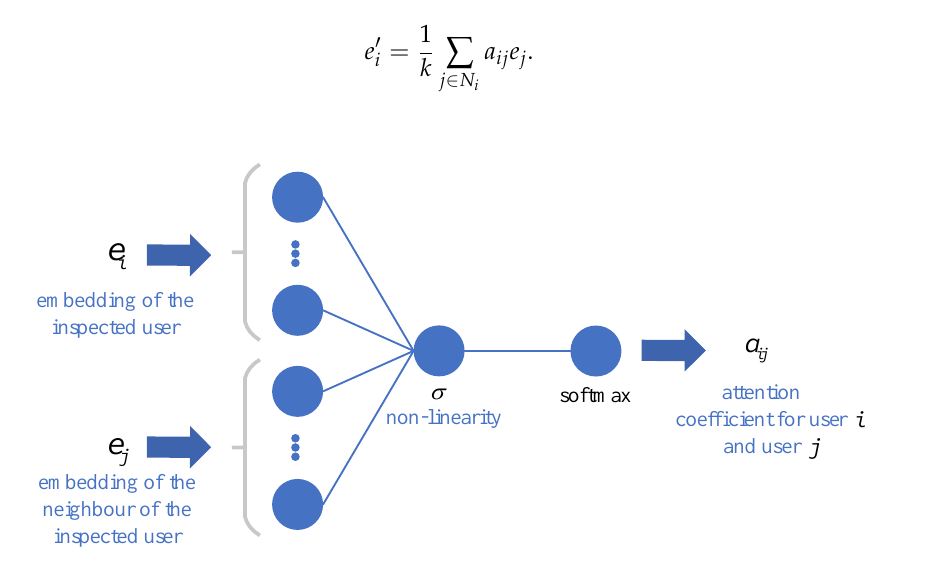
Figure 5. An illustration of the computation process to get the attention coefficient a ij